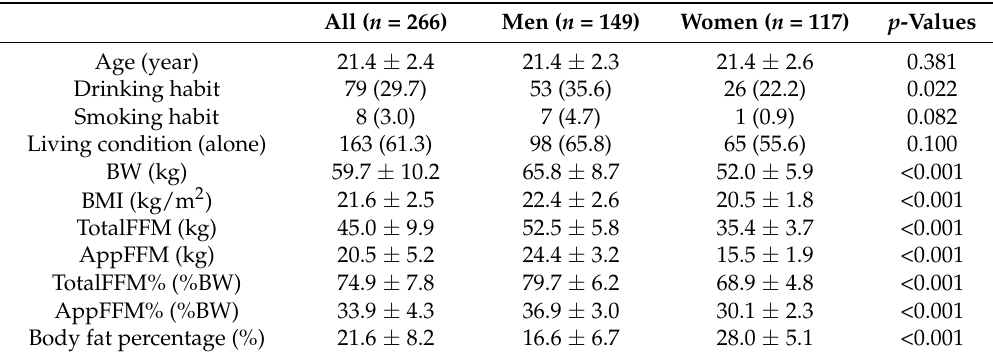
Table 1. Subject